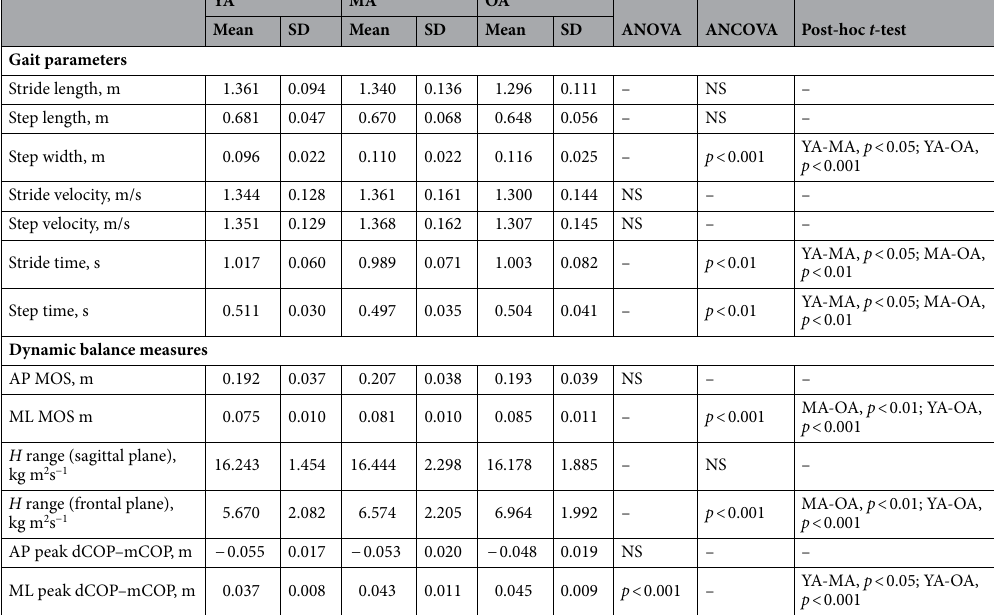
Table 1. Summary of ANOVA, ANCOVA, and post-hoc t -test for gait parameters and dynamic balance measures. ANCOVA one way analysis of covariance; ANOVA one way analysis of variance; AP anteroposterior; dCOP desired center of pressure; MA middle-aged adult group; mCOP measured center of pressure; ML mediolateral; MOS margin of stability; NS no significance; OA old adult group; YA young adult group.